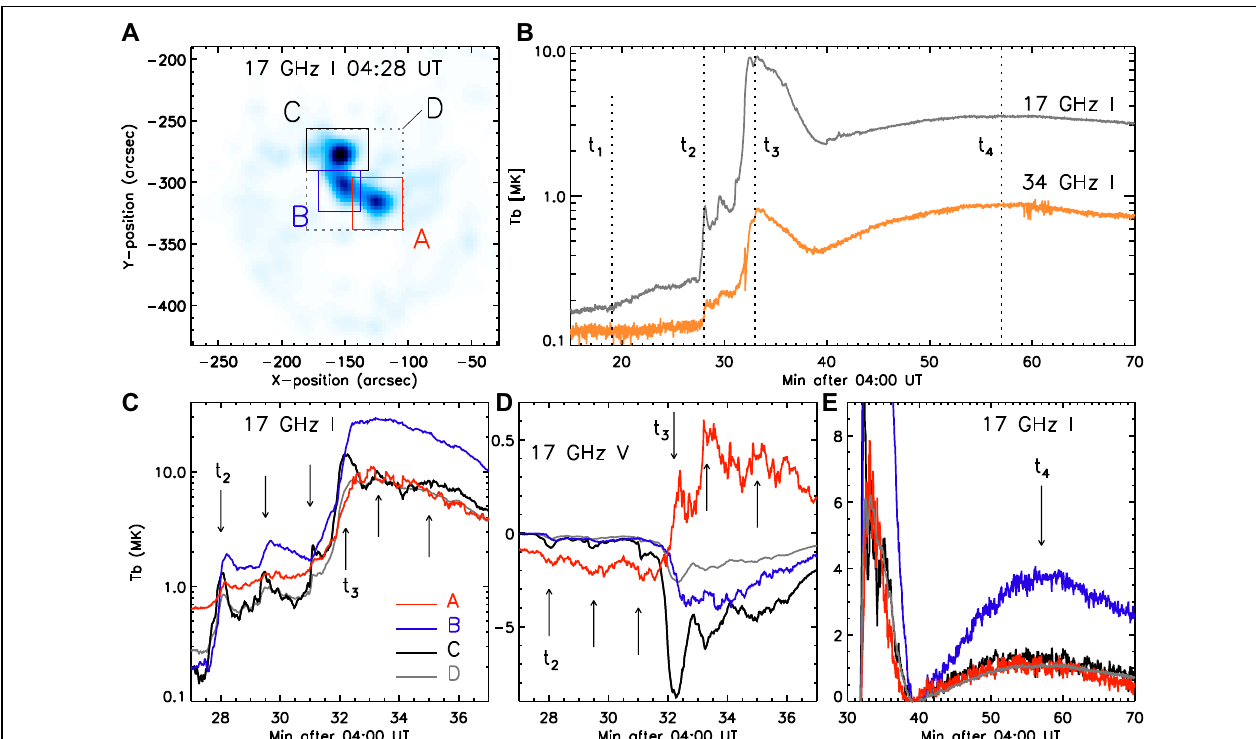
FIGURE 4 | Activation and pulsation of the microwave emission during the CRF. Four local regions denoted as A–D are set for calculating local average T b on the inverted 17 GHz map at t 2 (A) . The average T b from D are plotted along with the four transition times, t 1 – t 4 (B) marked with the vertical dotted lines. Time profiles of the total (C) and the polarized 17 GHz intensities (D) are plotted along with the arrows pointing to the temporally local peaks. Time profiles of the relative T b in a longer period including the late phase (E) show that the largest △ T b occurred in region B, the looptop. (Adapted from Lee et al.,